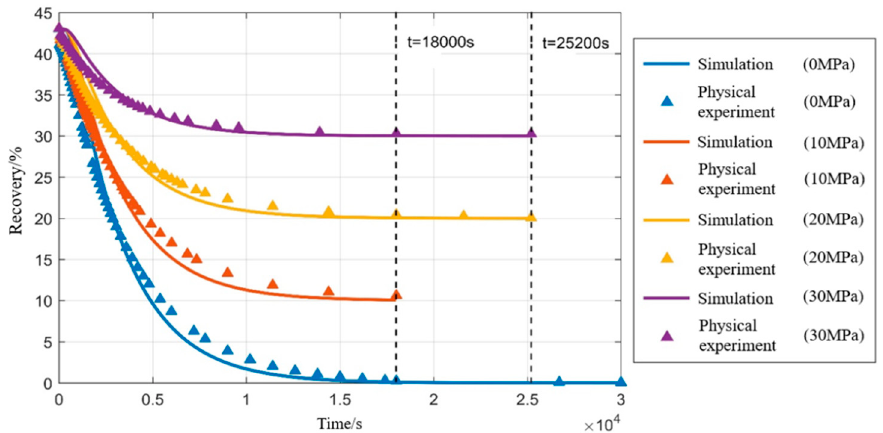
Figure 7. Comparison of numerical simulation and physical experiment under different upstream